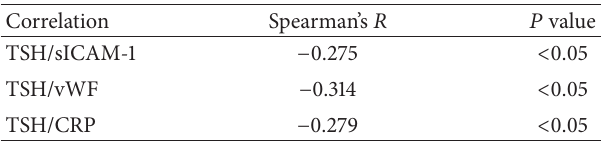
Table 5: Spearman’s rank correlation coefficients in the group with subclinical